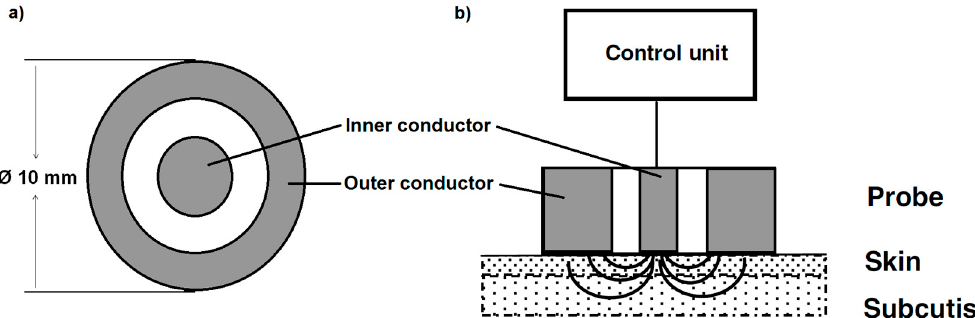
Figure 1. Magnified view of the measuring probe ( a ) and the measuring principle of the MoistureMeterD according to Nuutinen, Ikäheimo and Lahtinen [14] ( b ).